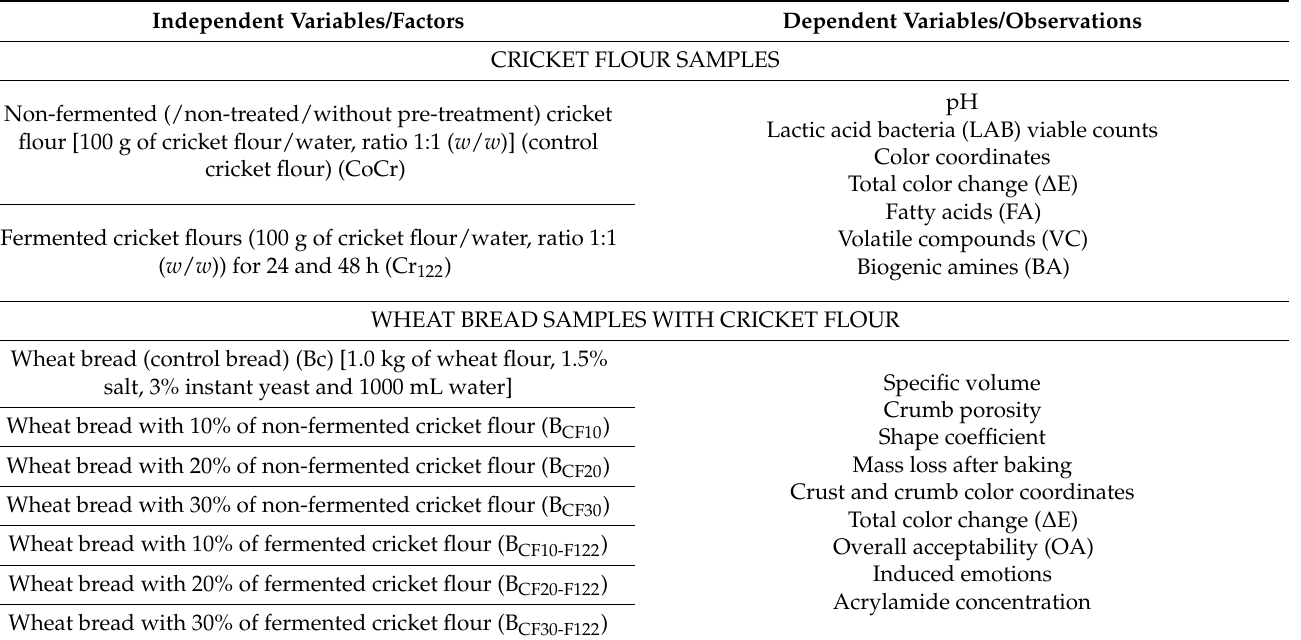
Table 1. Representation of the experimental design with definition of the factors and